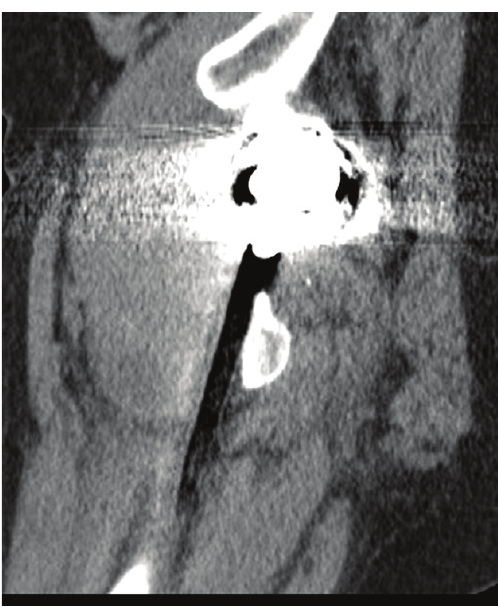
Figure 4: Sagittal section of CT scan showing the